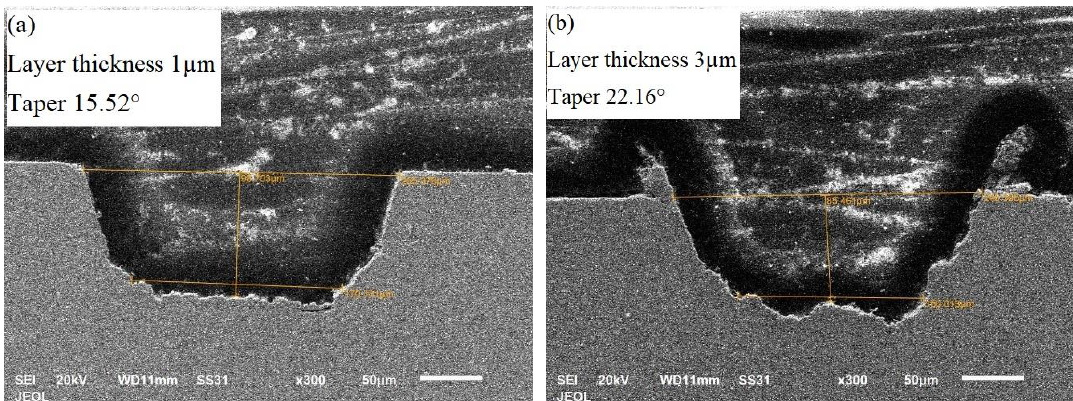
Figure 7. SEM images of the microchannel cross-section showing the variation of taper angle with layer thicknesses of ( a ) 1 µm and ( b ) 3 µm .